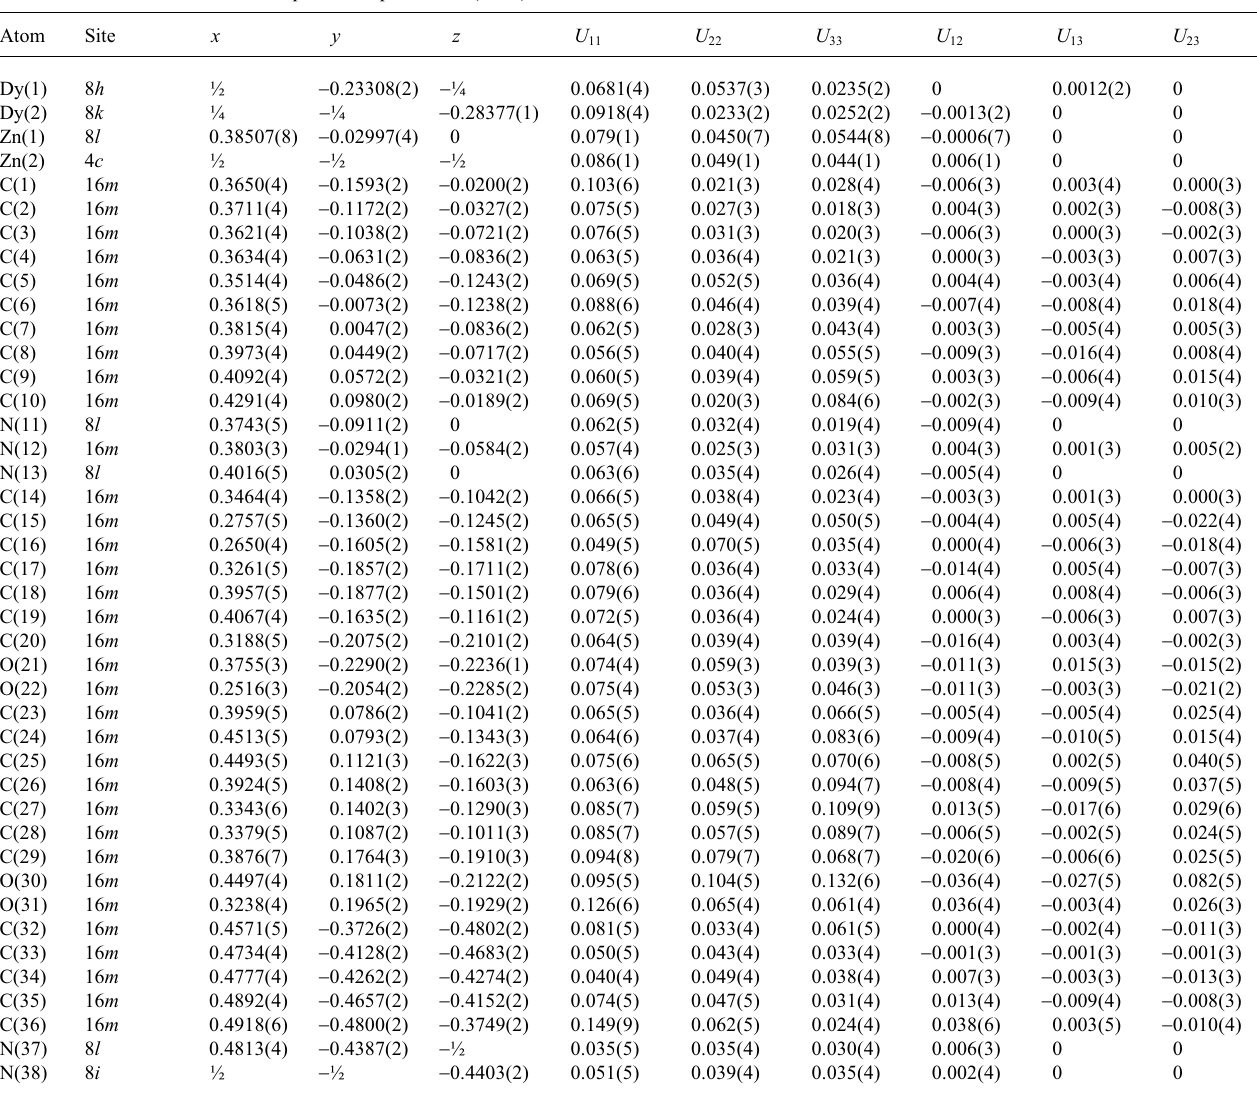
Table 3. Atomic coordinates and displacement parameters (in Å 2 ).